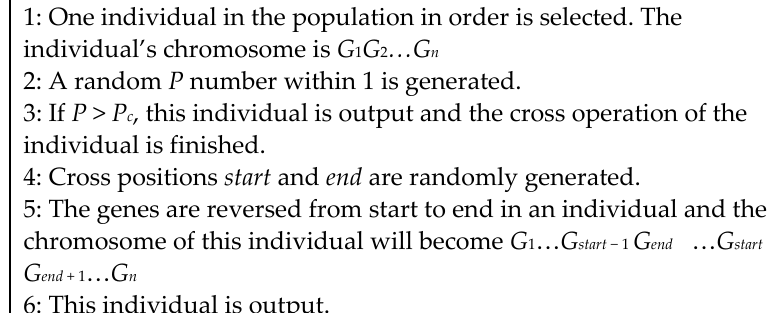
Figure 20. The mutation operation.